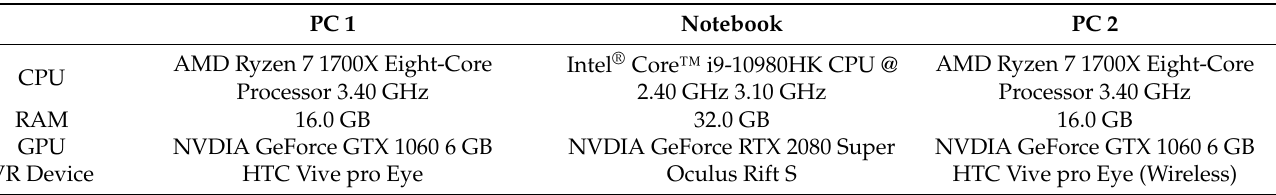
Table 1. Experiment